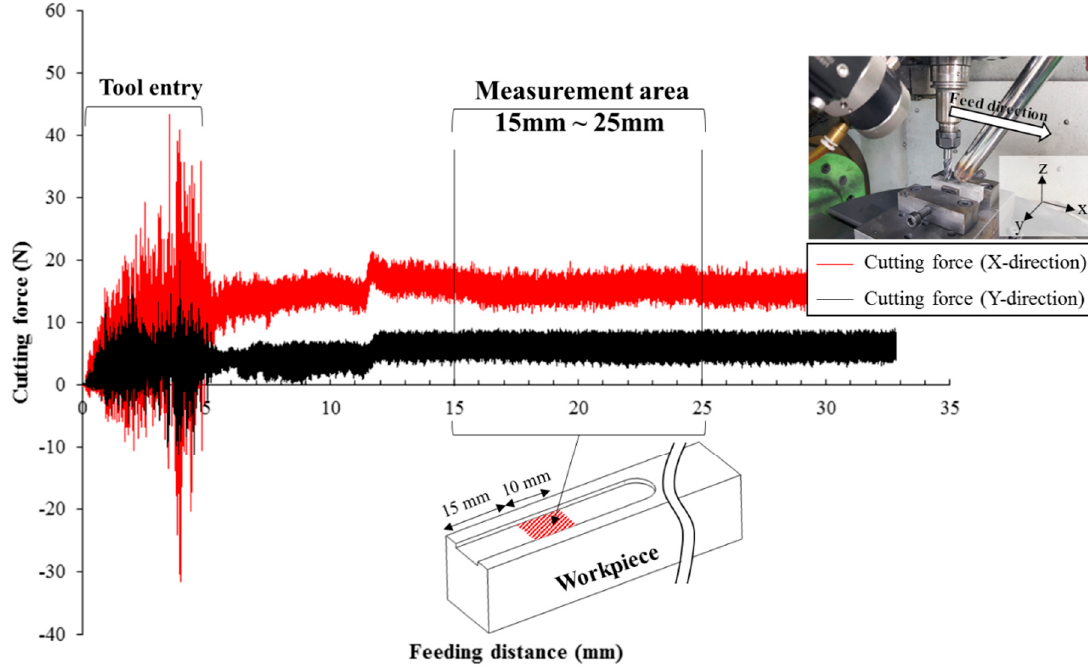
Figure 7. Measurement area of the cutting force and surface roughness.